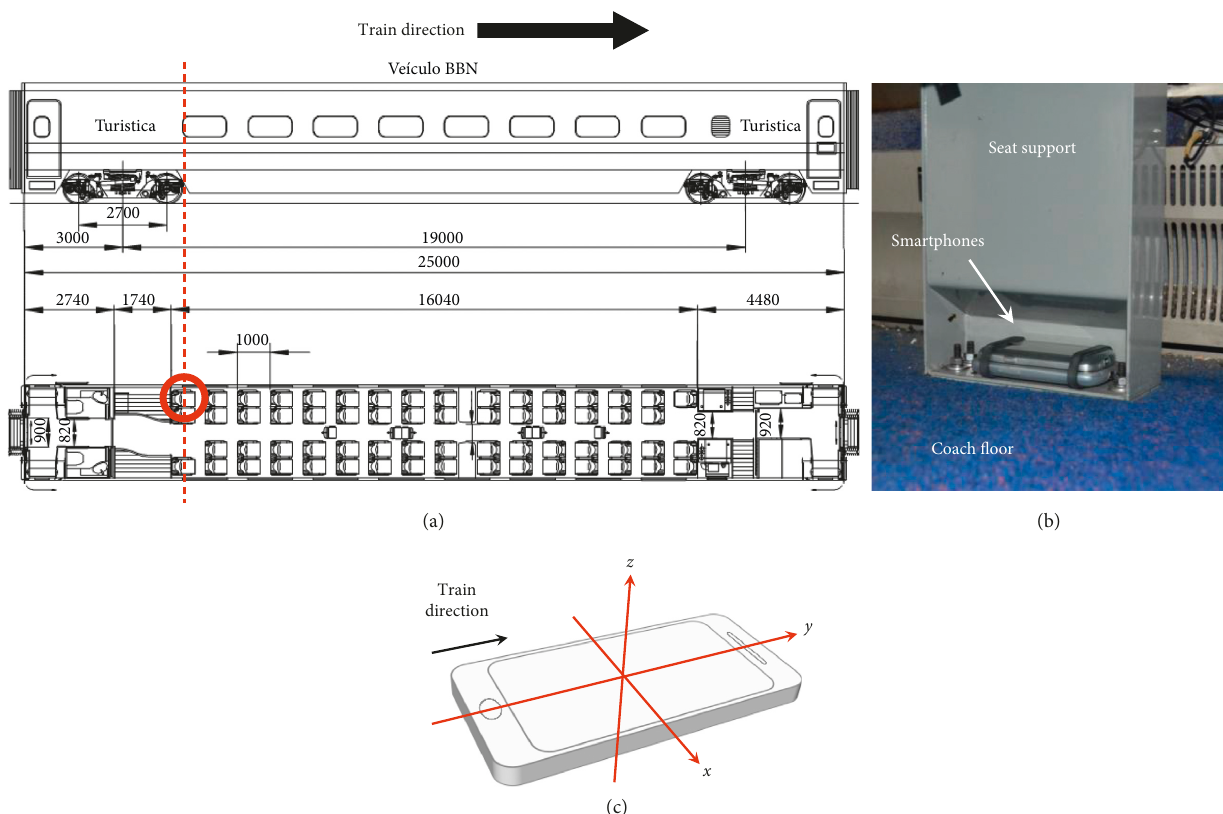
Figure 2: Location of the smartphone inside the coach car (a, b) and schematic representation of the orientation of the accelerometers’ axes x , y , and z (c).